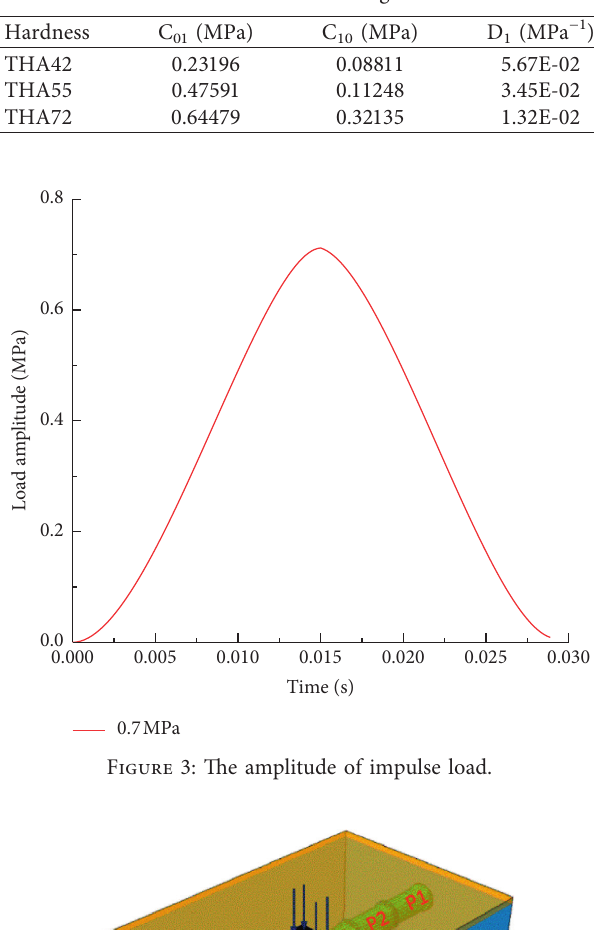
Table 2: Parameters of gasket.